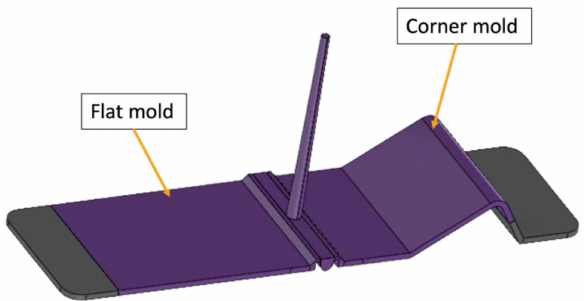
Figure 1. Mold design.